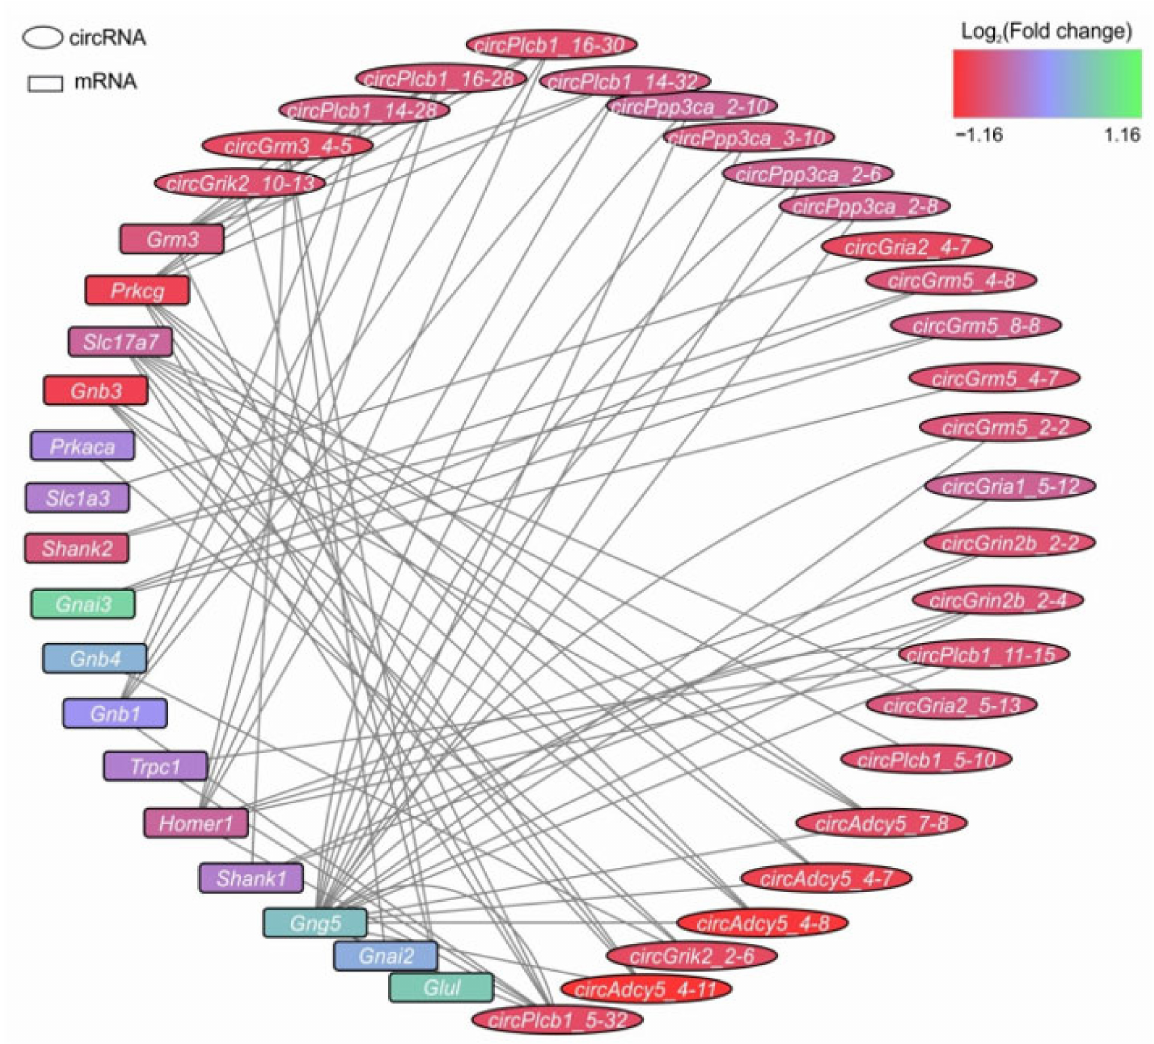
Figure 6. The circRNA–miRNA–mRNA regulatory network for DECs and DEGs, associated with the signaling pathway ‘glutamatergic synapse’. The network was constructed using Cytoscape 3.8.2 software. The nodes are designated the mRNAs or circRNAs. Each line connecting the nodes indicates the interaction of the corresponding mRNAs and circRNAs with common miRNAs. Accordingly, a different number of lines connecting the nodes indicates a different number of miRNAs, for the interaction with which circRNAs and mRNAs compete. The cut-off for circRNA-expression changes was 1.50. Only those circRNAs whose Padj < 0.05 were selected for